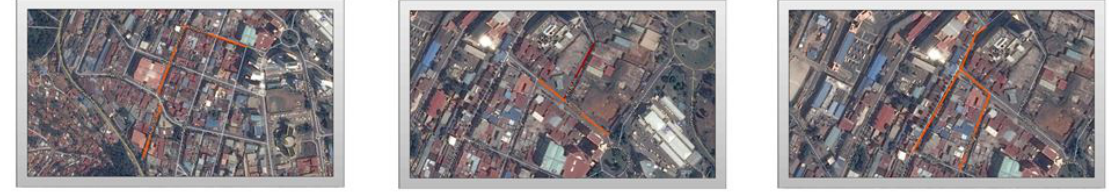
Figure 16. Physical Positions of the optimal Parking(Commercial)